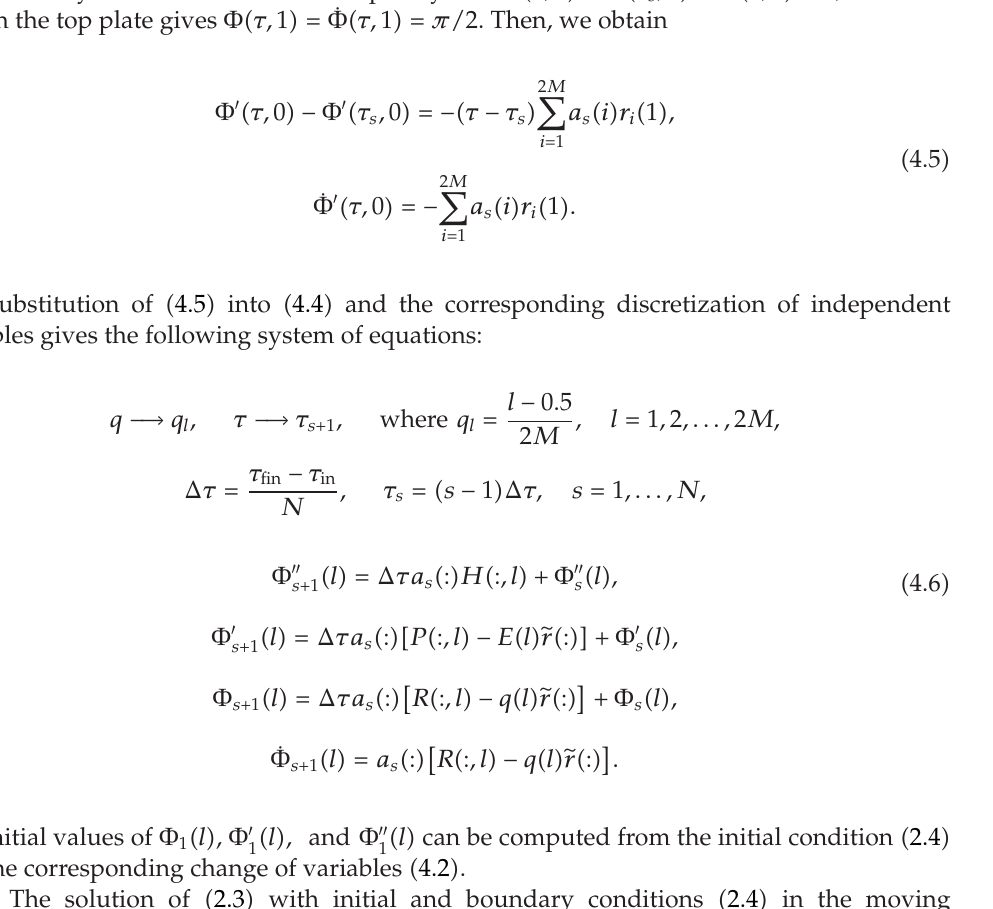
The boundary condition on the bottom plate yields Φ(cid:2) τ, 0 (cid:3) (cid:7) Φ(cid:2) τ s , 0 (cid:3) (cid:7) ˙ Φ(cid:2) τ, 0 (cid:3) (cid:7) 0, while